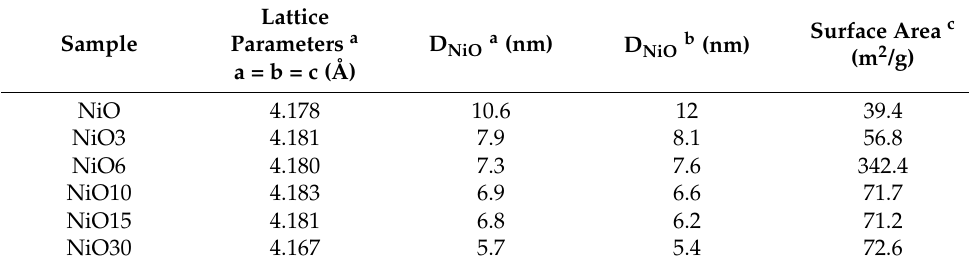
Table 1. Structural parameters, particle size and surface area from Sn doped and undoped NiO samples.